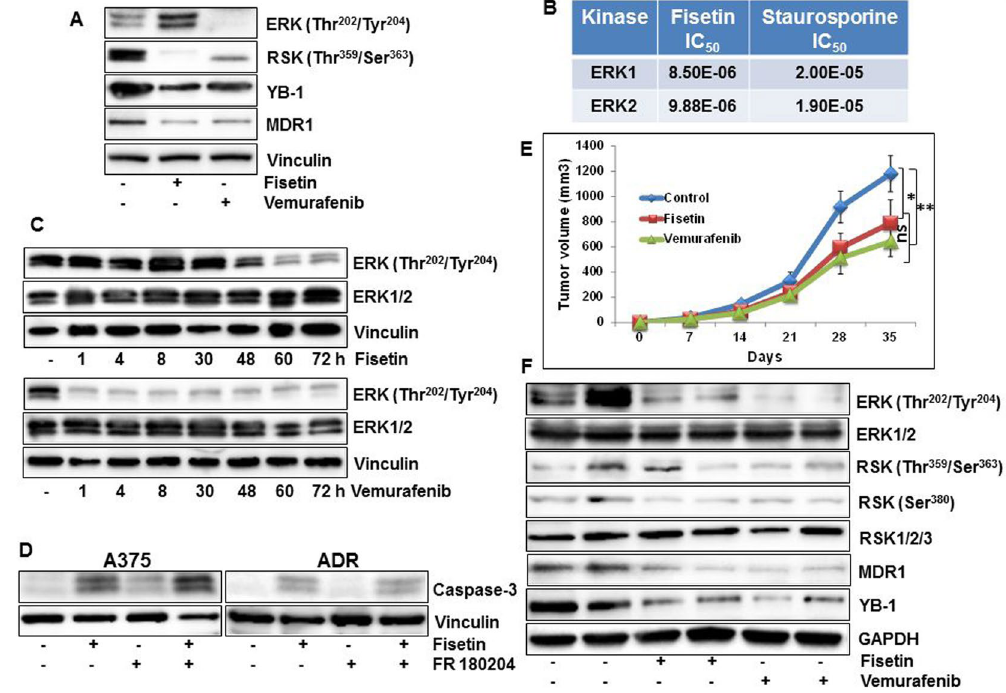
Figure 6. Comparable inhibition of melanoma tumor growth by fisetin and vemurafenib albeit through divergent regulation of ERK signaling ( A ) Whole cell lysates of A375 melanoma cells treated with fisetin (60 µ M) or vemurafenib (10 µ M) for 24 h were analyzed for phosphorylated RSK, ERK1/2, total YB-1 and MDR1. Equal loading was confirmed by reprobing for vinculin. ( B ) Kinase inhibitory activity for ERK1/2. Fisetin was tested in 10-dose IC 50 mode with 3-fold serial dilution starting at 100 μ M. Reactions were carried out at 30 μ M ATP. ( C ) Whole cell lysates of A375 melanoma cells treated with fisetin (60 µ M) or vemurafenib (10 µ M) for specified time points analyzed for phosphorylated and total ERK1/2. Equal loading was confirmed by reprobing for vinculin. ( D ) Whole cell lysates of A375 melanoma and NCI/ADR-Res ovarian cancer cells, treated with fisetin (60 µ M) and/or ERK1/2 inhibitor FR180204 (10 µ M) for 24 h were analyzed for cleaved caspase-3 expression. Equal loading was confirmed by reprobing for vinculin. ( E ) Average tumor volume of DMSO/fisetin/vemurafenib-treated mice plotted over days after tumor cell inoculation. Points, mean of 12 tumors in six animals; bars, mean ± SE, * p ≤ 0.05, ** p ≤ 0.01 versus the control group. ( F ) Whole cell lysates of tumor tissues analyzed by western blot. Equal loading was confirmed by reprobing for GAPDH. Data represent samples from each group repeated twice with similar